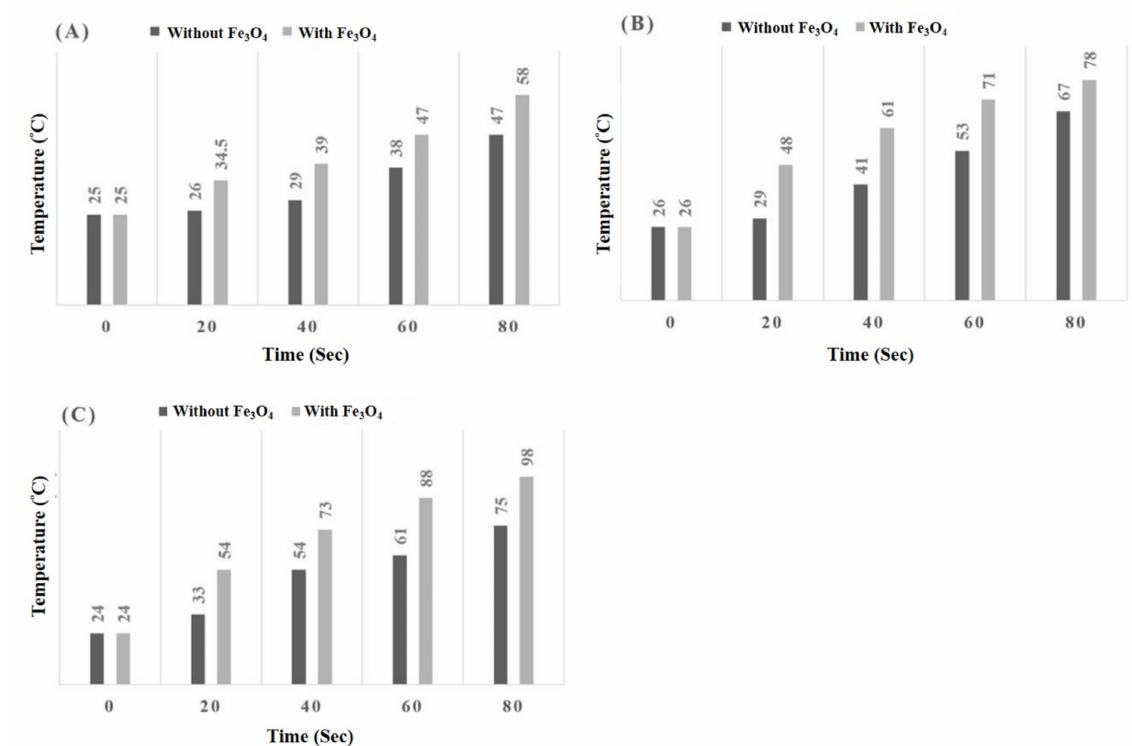
Figure 3. Comparisons of the co-catalytic and non-co-catalytic temperatures at microwave powers of ( A ) 266 W, ( B ) 532 W, and ( C ) 800 W for various batch tests (presence or absence of 50 g of Fe 3 O 4 catalyst with a feedstock oil volume of 80